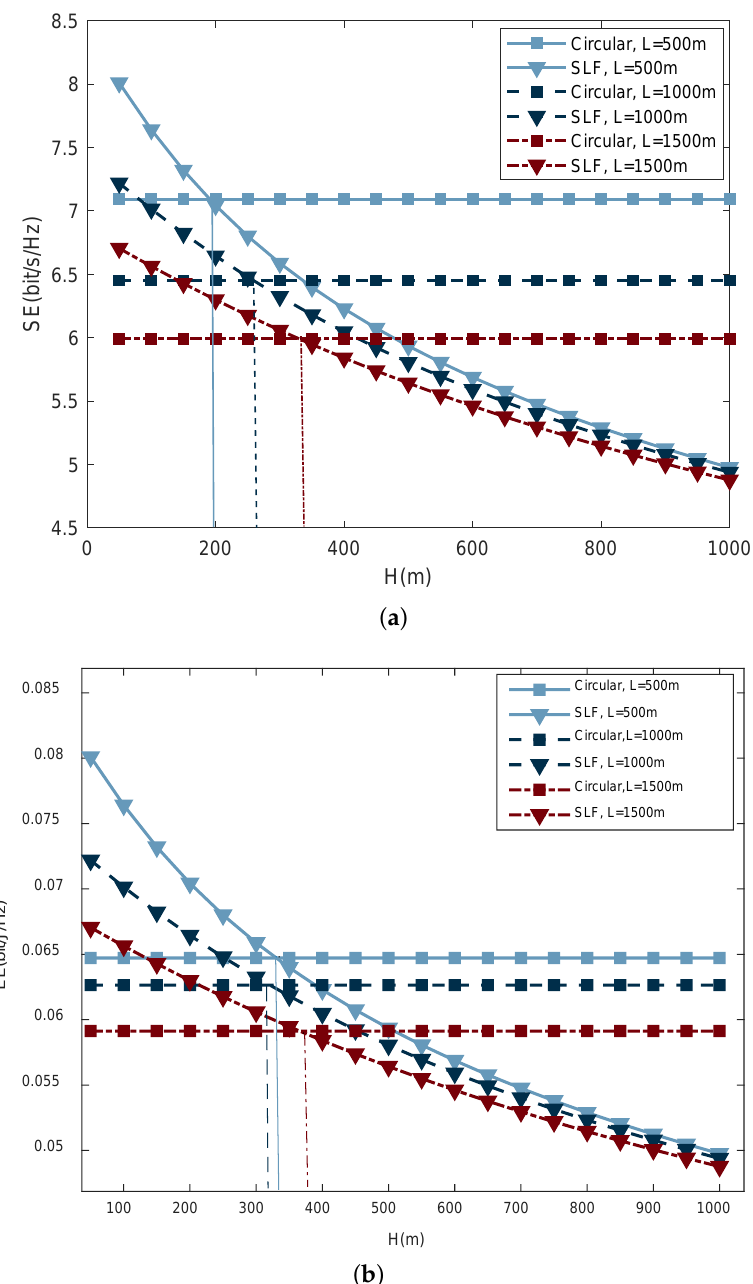
Figure 5. SLF trajectory vs. circular trajectory. ( a ) SE comparison. ( b ) EE